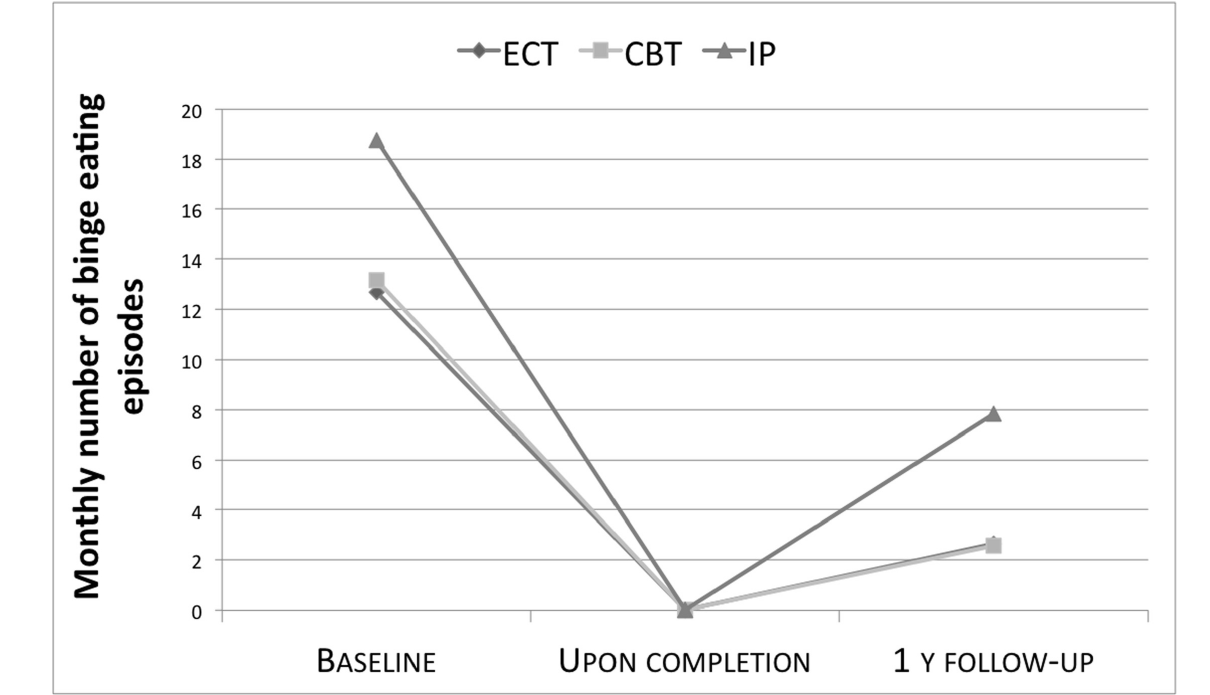
Figure 3. Monthly mean number of binge eating episodes at baseline, at the end of the inpatient treatment and at 1-year follow-up (dropouts at follow-up are assumed to have regained the baseline score).